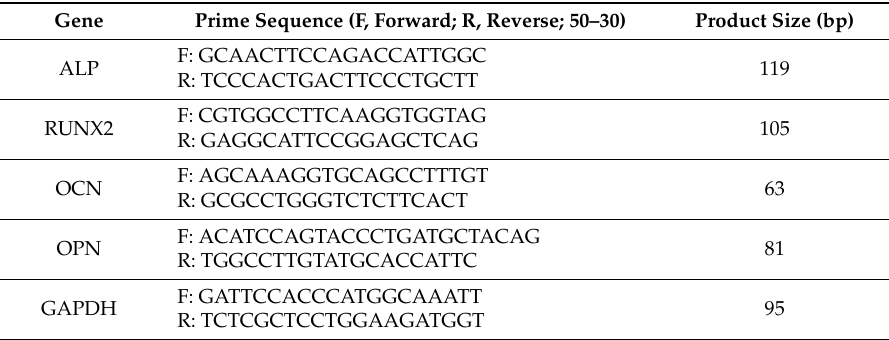
Table 1. PCR Primers for ALP, RUNX2, OCN, OPN, and GAPDH.